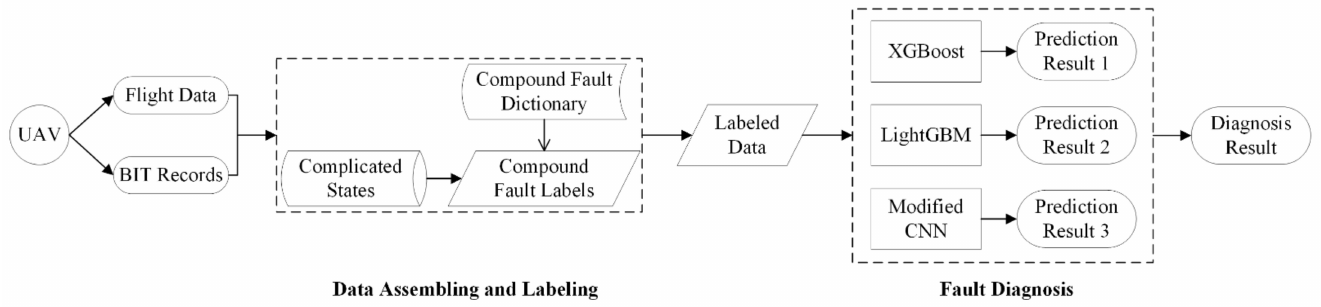
Figure 1. Flowchart of the proposed compound fault labeling and diagnosis method based on actual flight data and Built-In-Test (BIT) records of an Unmanned Aerial Vehicle